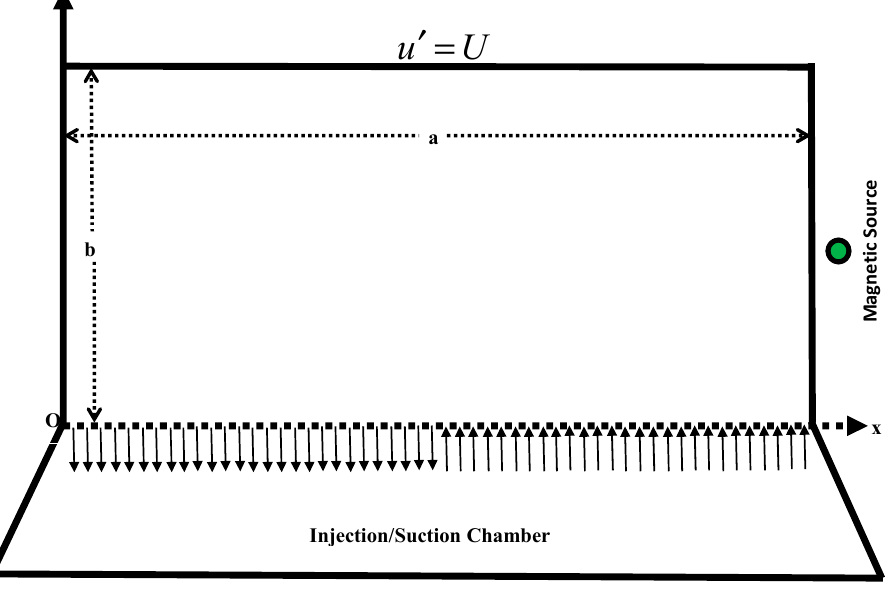
Figure 1. Two-dimensional (cross-sectional) view of the cavity of the problem.